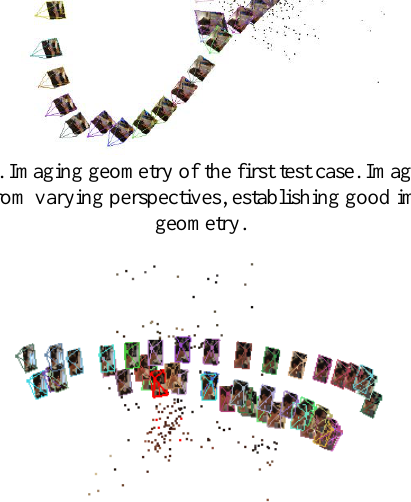
Figure 7. Imaging geometry of the second test case. Imaging geometry is not as strong as in the first test case because images were taken along a nearly horizontal trajectory. Fig. 8 and Fig. 9 visualize 5x5x5 grids of the imaging geometry from the first and the second test cases, respectively. In each green voxel, there exists one or more camera locations. Oblique views reveal the 3D structure of the imaging geometry. The top views demonstrate how even such limited illustrations show a clear difference in imaging geometries.